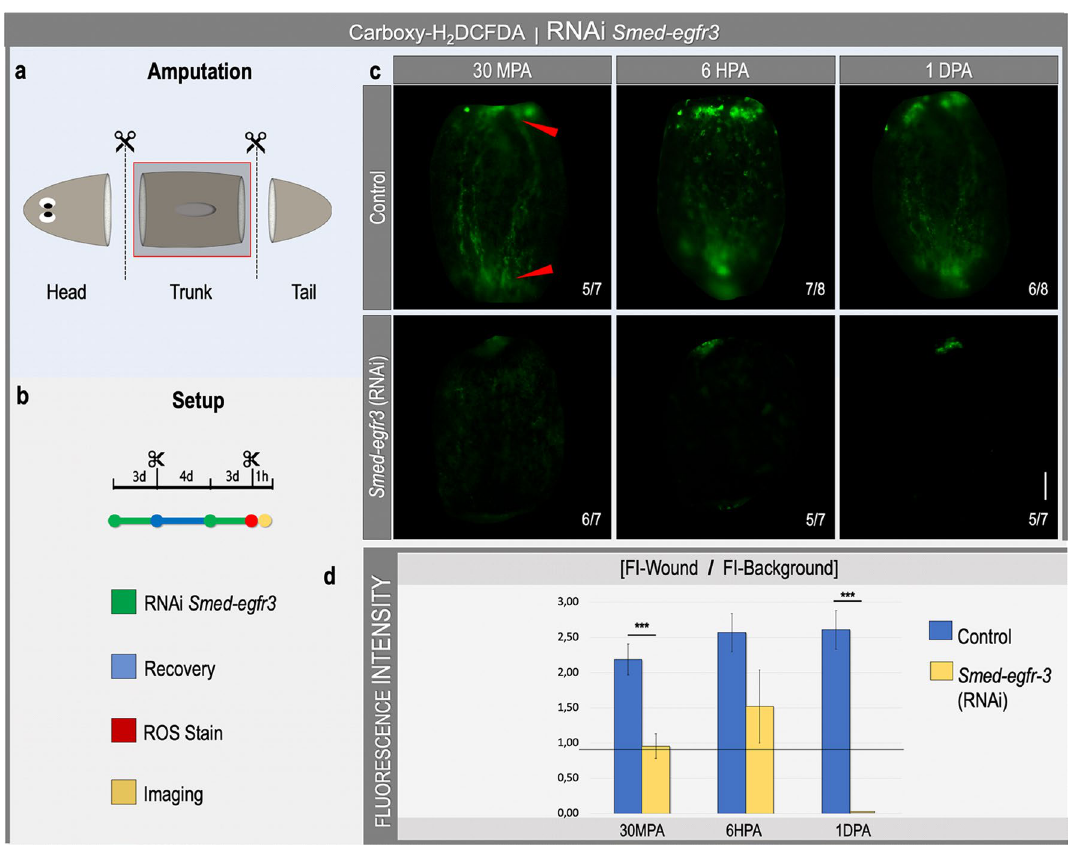
Figure 5. ROS production is regulated by Smed-egfr-3 during early regeneration. ( a ) The amputation setup is displayed in the grey box, indicating the amputation sites. The red square corresponds to the images shown in (c). ( b ) The experimental setup is displayed in the light grey panel. Color code as follows; green: Smed-egfr3 RNAi (2 rounds of 3 consecutive days), blue: recovery in fresh medium (4 days), red: general ROS stain using carboxy-H 2 DCFDA, yellow: imaging procedure. ( c ) In vivo visualization of amputation-induced ROS levels 30 min-, 6 h- and 1 day post amputation (MPA, HPA, DPA) in controls and Smed-egfr-3 RNAi fragments. All pictures were taken under the same light intensity settings. Sample numbers are indicated in the images. Scale bar 100 µm. ( d ) Relative fluorescence intensity of the wound region. Color code as follows; dark blue: control, yellow: Smed-egfr-3 (RNAi). Statistical significance is indicated by: * p < 0.05; ** p < 0.01; *** p <